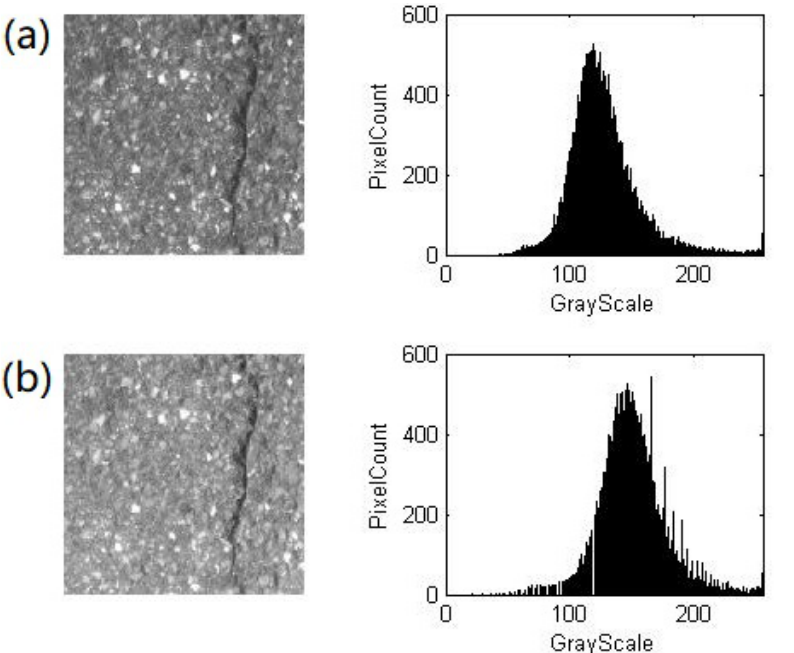
Figure 2. An image of highway pavement and its histograms of the grayscale ( a ) before and ( b ) after the Gamma